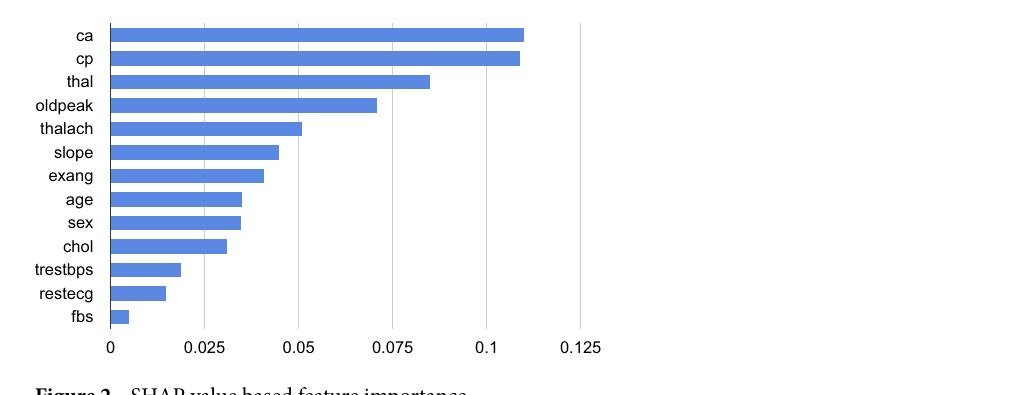
Figure 2. SHAP value based feature